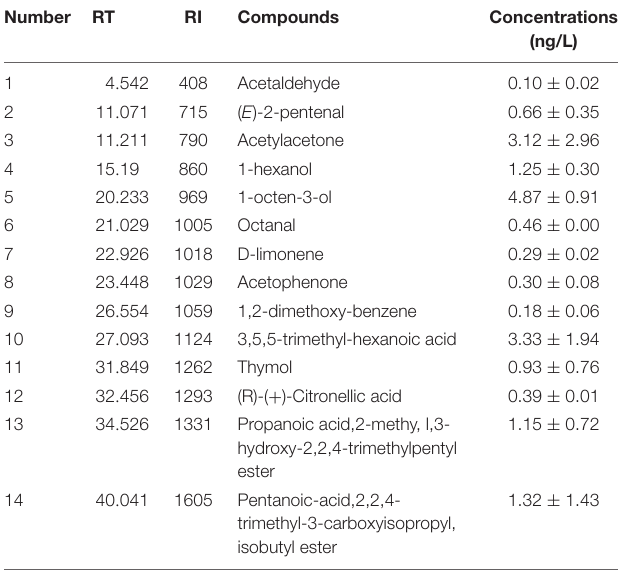
TABLE 2 | Metabolites in the E. cristatum culture filtrate identified by GC/MS. Number